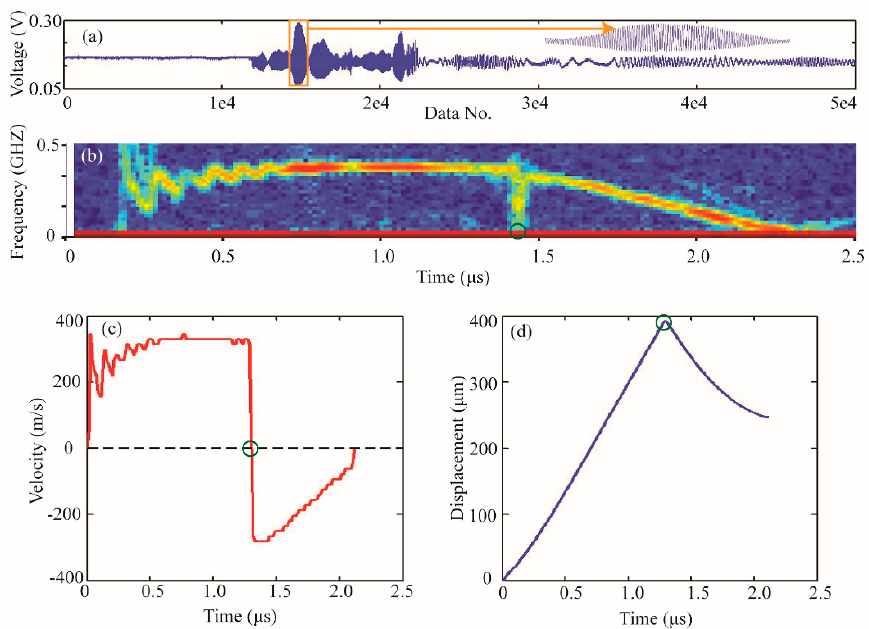
Figure 5. ( a ) Data from the detector of Photon Doppler Velocimetry, ( b ) beat frequency of the flyer, ( c ) flyer velocity, ( d ) flyer travel distance, ( E = 3.1 J, D = 2 mm, t = 250 μ m).